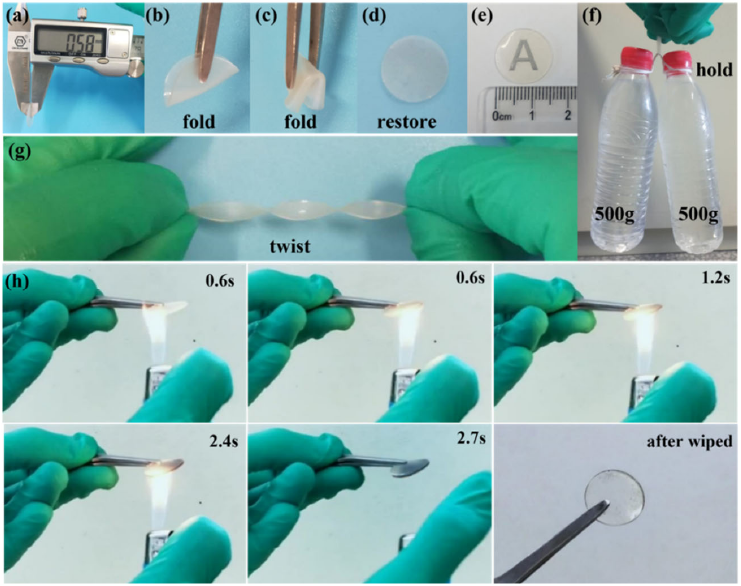
Figure 5. ( a – g ) Physical properties of GPE; ( h ) combustion experiments of GPE.